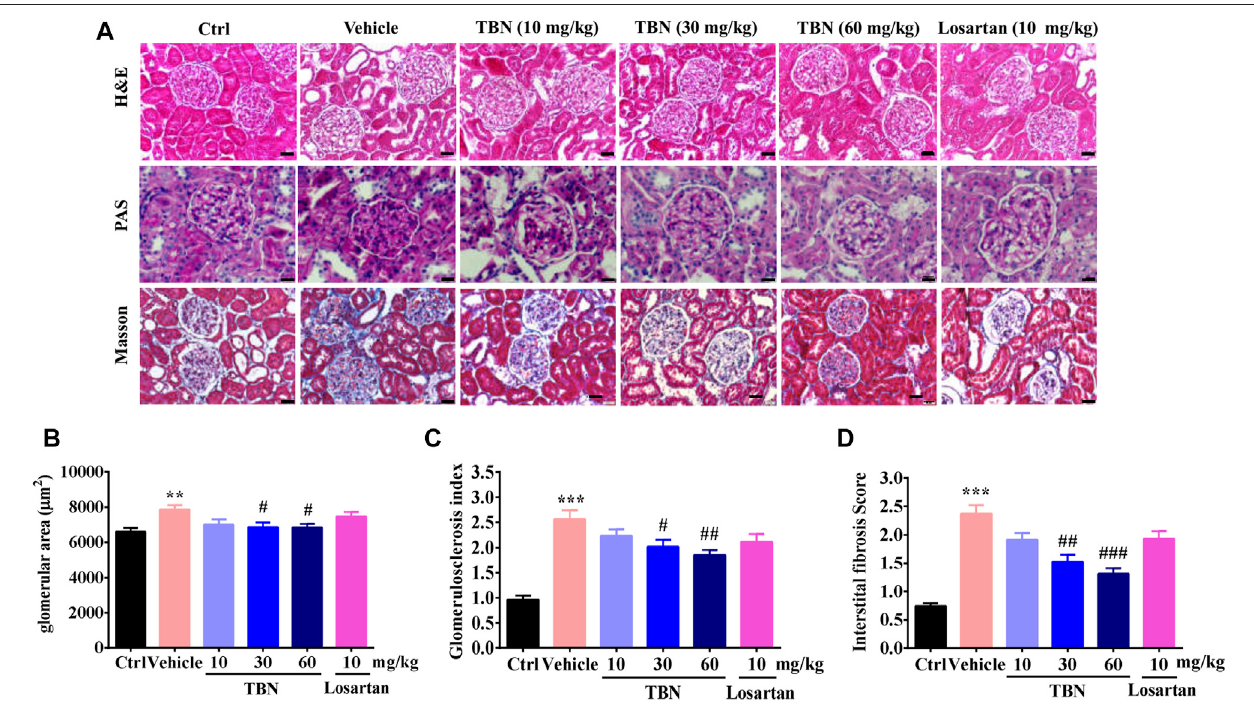
FIGURE2| TBNreducesglomerular pathologicalchangesinSTZ-inducedrats. (A) RepresentativephotomicrographsofH&Estaining,PASstaining,and Masson staining in the kidney. Scale bars, 50 μ m in H&E and PAS staining, and 20 μ m in Masson staining. ( B-D ) Semi-quantitative analysis of glomerular surface area, glomeruloscleroticindexandtubulointerstitial fi brosisindexwereshown.30imagesofH&E,PAS,andMasson-stainedkidneysectionswerecountedforeachrat. n (cid:1) 13 for vehicle-treated DM group and n (cid:1) 16 for other